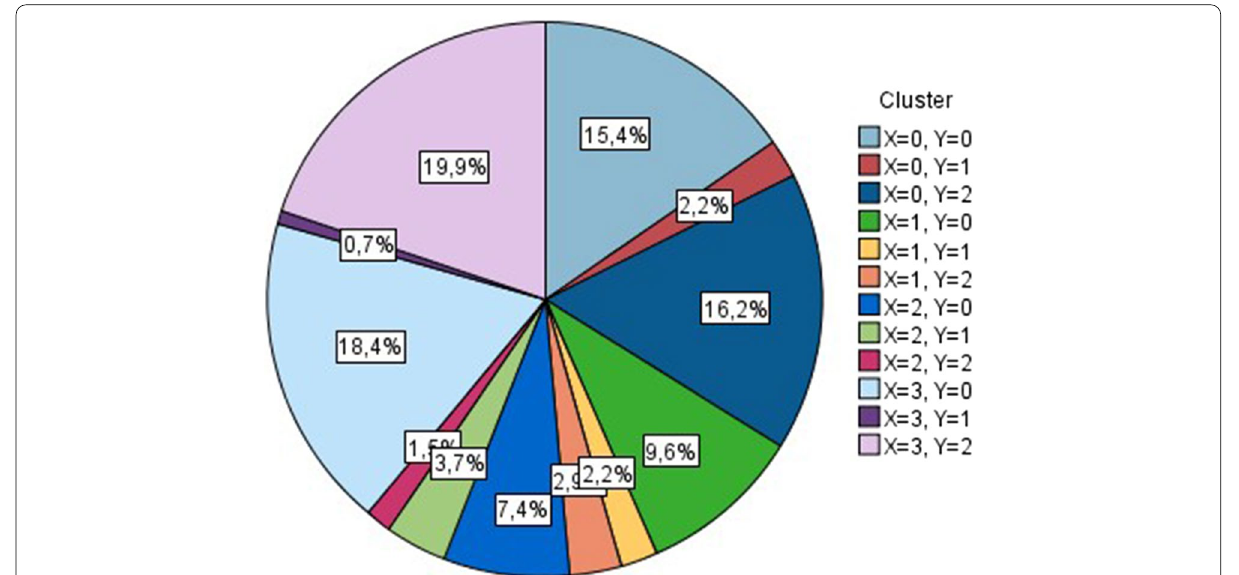
Fig. 3 The distribution of clusters in the SOM model